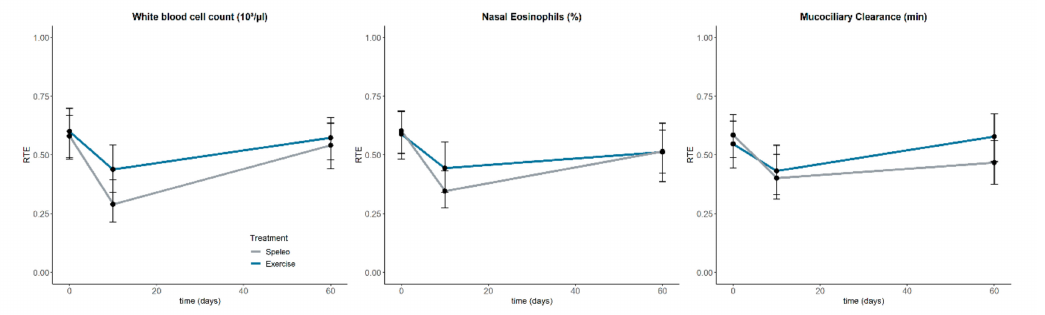
Figure 5. Relative treatment e ff ects (RTE) of the white blood cell count ( Left ), the nasal eosinophilic cell count (middle) and the muco-ciliary clearance time ( Right ). Error bars represent upper and lower confidence interval of the